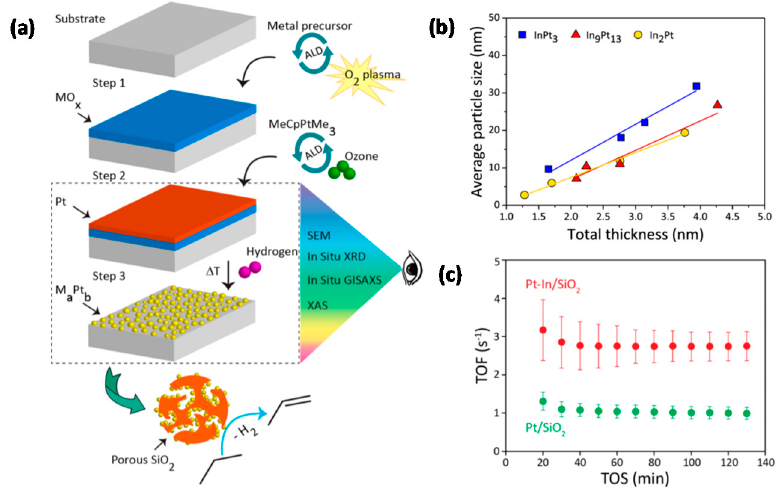
Figure 16. ( a ) Schematic representation of an ALD method to synthesize bimetallic PtM NPs (where M = In or Ga) on planar or porous SiO 2 : (step 1) MO x layer deposition via ALD, (step 2) deposition of a Pt layer via ALD and (step 3) conversion of the bilayer into PtM NPs via H 2 -TPR. In the same study, SEM, XAS, in situ XRD and GISAXS were applied to examine the bilayer-to-NP conversion. ( b ) Average particle size (determined by SEM analysis after TPR in 10% ( V / V ) H 2 / N 2 up to 700 ◦ C) as a function of total layer thickness for various PtIn phases prepared by the bilayer method. Solid lines are linear trends fitted to the experimental data. ( c ) TOF values for propylene production as a function of TOS for ALD-prepared InPt 3 / SiO 2 and Pt / SiO 2 in PDH at 600 ◦ C. Reaction conditions: W cat / F C3H8,0 = 20 kg cat s mol –1 and P C3H8,0 = 20 kPa, total pressure = 101.3 kPa. Adapted with permission from Ref.